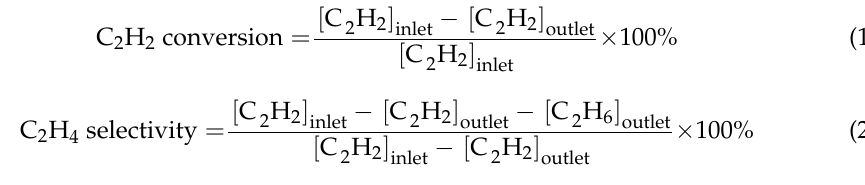
Table S2: ICP-OES analysis of catalysts. Figure S1: Schematic illustration of Pd NCs and Pd NCs@Bi synthesis. Figure S2: HRTEM image and size distribution of 20 nm sized Pd NCs. Figure S3: HRTEM image and EDS elemental maps of Pd NCs@Bi 0.25 using NaBH 4 as reductant. Figure S4: HRTEM images of Pd NCs@Bi 0.25 using NH 3 · BH 3 -NaOH as reductant. Figures S5–S8: HRTEM images and Figure S10: HRTEM image and size distribution of 7 nm sized Pd NCs. Figure S11: HRTEM images and line scanning profile of Pd 7nm NCs@Bi 0.5 . Figure S12: XRD patterns of Pd NCs/Al 2 O 3 and Figure S14: Catalytic performances of Pd 7nm NCs@Bi x /Al 2 O 3 catalysts in acetylene hydrogenation. Figure S15: Schematic illustration of Pd NPs@Bi-based catalysts synthesis. Figure S16: Catalytic performances of Pd NPs@Bi based catalysts in acetylene